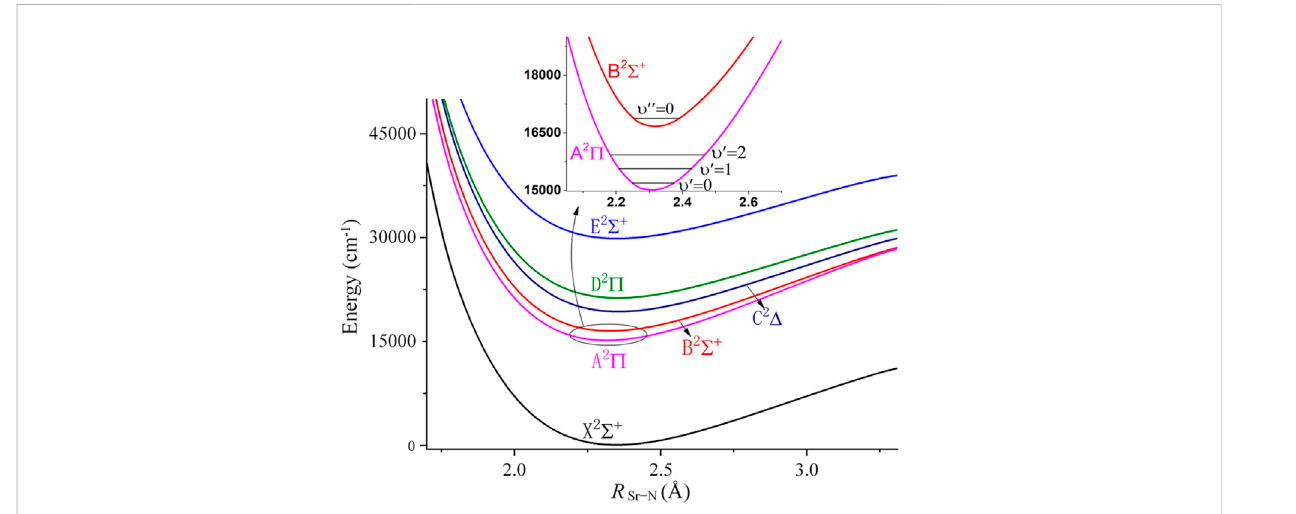
FIGURE 2 Potential energy curves of linear SrNC along R Sr-N , with R N-C fi xed at